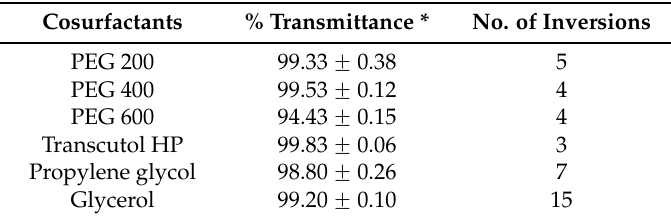
Table 3. Emulsification Efficiency of Various